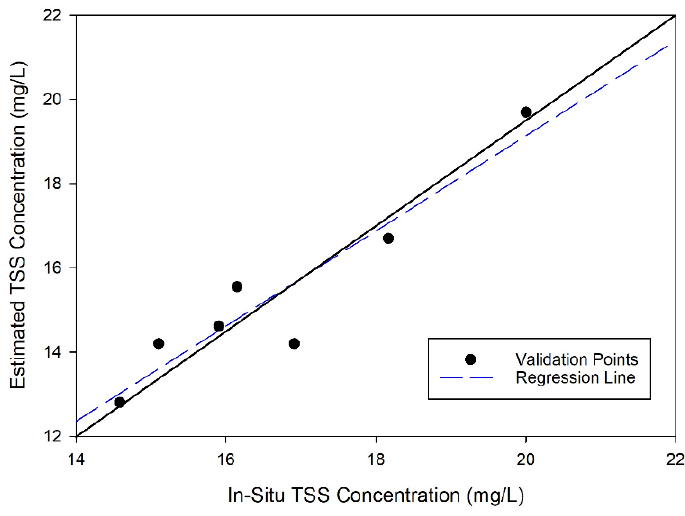
Figure 4. Validation graph of the TSS Concentration.